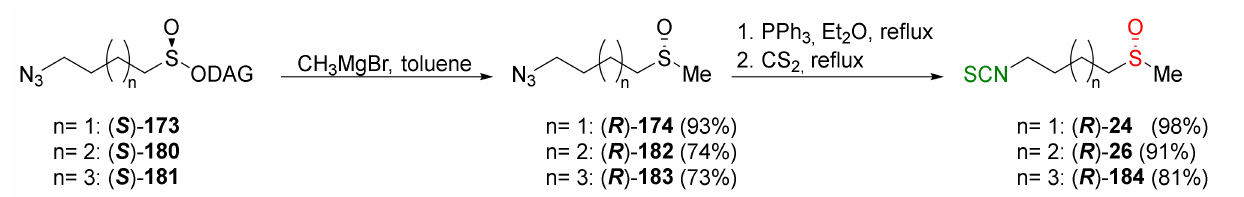
Figure 30. Synthesis of enantiopure ( R )-SFN (( R )- 24 ), ( R )-alyssin (( R )- 26 ), and their homologue (R )- 184 .